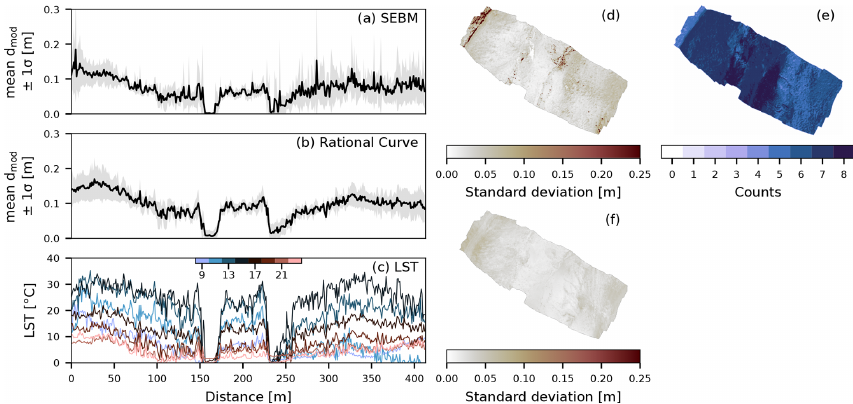
Figure 9. Diurnal mean ± 1 σ debris-thickness predictions along the profile line shown in Fig. 1. (a) The predictions using the surface energy balance model (SEBM) show a larger spread of the standard deviation (grey) towards the edges and smaller towards the central part corresponding to regions of thicker and thinner debris cover. Panel (b) shows the results of the rational curve extrapolation approach. A smaller spread indicates greater consistency in the prediction over the day. (c) The diurnal variability of the land surface temperature along the profile line. Panels (d, f) show the spatial variation of the standard deviation and (e) the number of valid solutions in the SEBM approach.